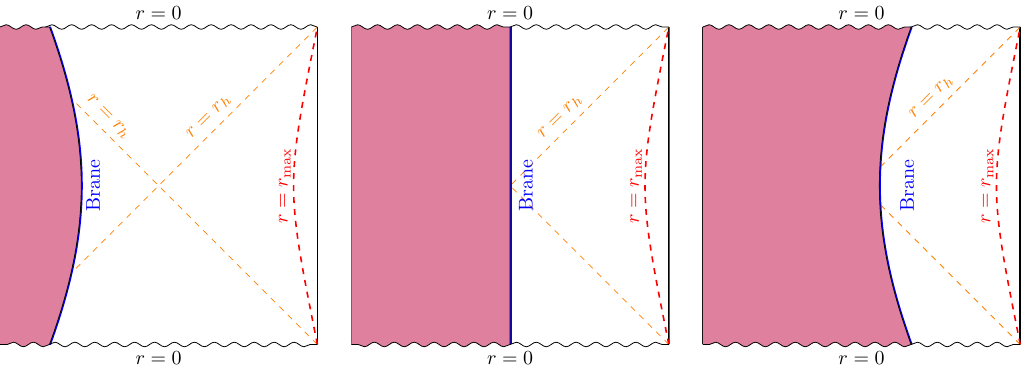
Figure 1 . Penrose diagram of a two-sided AdS-Schwarzschild black hole excised by a dynamical ETW brane for: left) T > 0, middle) T = 0, and right) T < 0. The brane is indicated by a thick blue curve and the purple region behind it, is cut form the black hole background. Moreover, the UV cuto(cid:11) surface at r = r max is shown by the red dashed